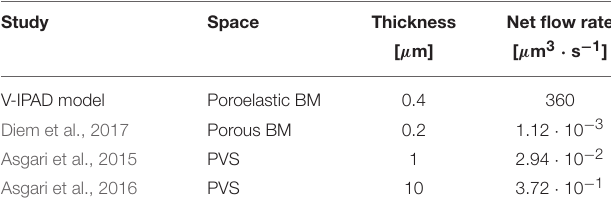
TABLE 2 | Comparison of results between the V-IPAD model and previous models.